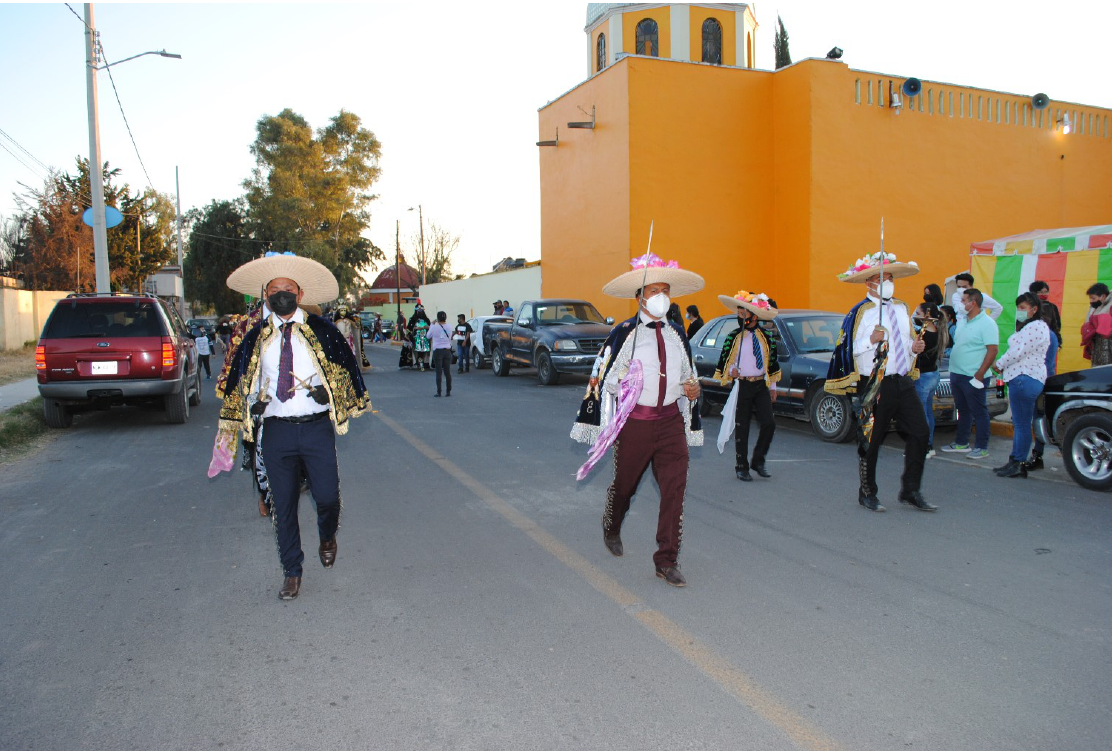
Figure 7 Santiagos dancers during the celebration of the feast of the Virgin of Candlemas, 2021, San Antonio Tepetitlán, Chiautla, State of Mexico. Copyright: Eladio Cerón